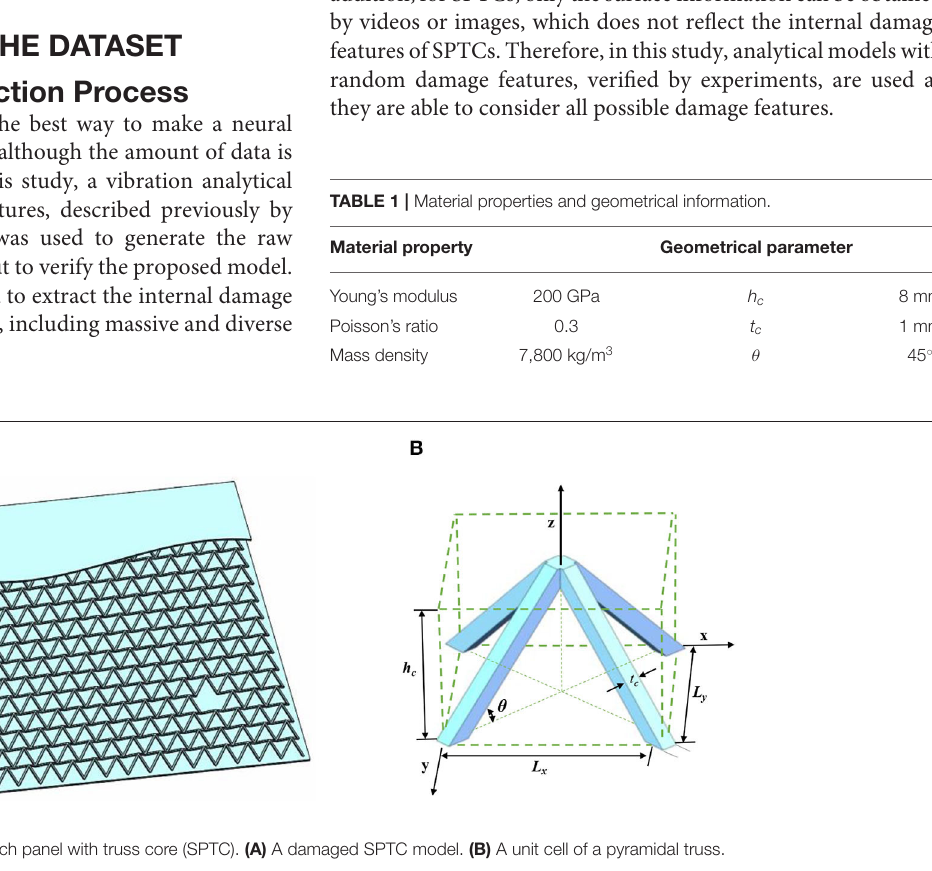
Frontiers in Materials |